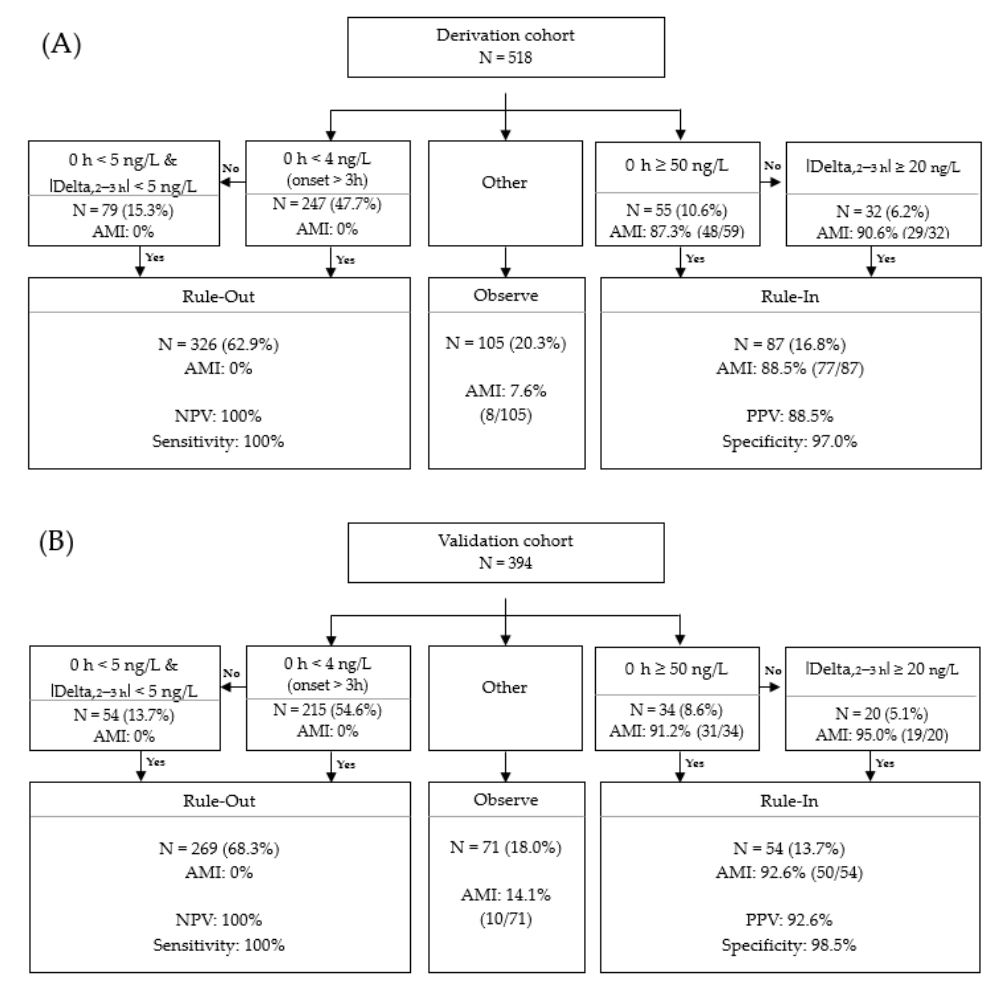
Figure 5. Internal validation with the derivation cohort ( A ) and validation cohort ( B ) regarding the 0/2–3 h algorithmic approach for AMI diagnosis using Access hs-TnI values at ED.